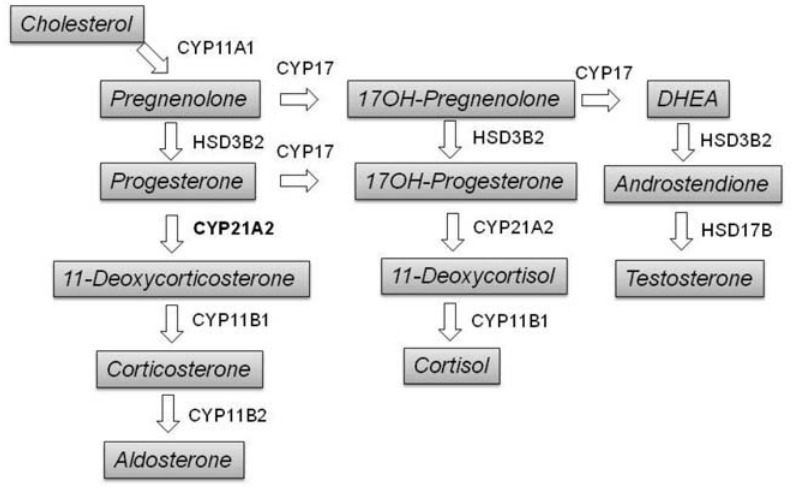
Figure 1. Synthesis of adrenal steroid hormones from cholesterol. Legend: The step that can be augmented by extraadrenal hydoxylation via hepatic cytochrome P450 CYP2C19 is bolded. CYP11A1 – cholesterol side-chain cleavage enzyme; CYP17 – 17-alpha-hydroxylase / 17,20-lyase; HSD3B2 – 3 β -hydroxysteroid dehydrogenase; CYP21A2 – steroid 21-hydroxylase; CYP11B1- steroid 11- β -hydroxylase; CYP11B2 – aldosterone synthase; 17 β -HSD – 17-beta-hydroxysteroid